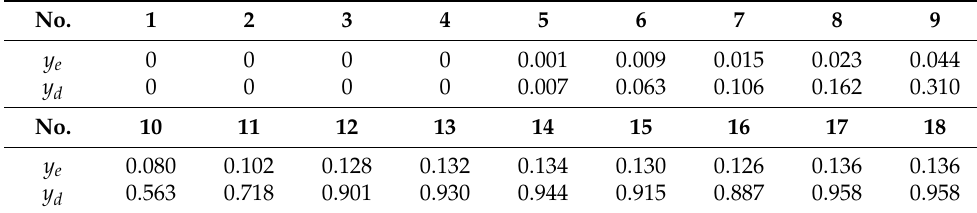
Table 5. The relationship between energy release efficiency y e and reaction degree y d obtained from the